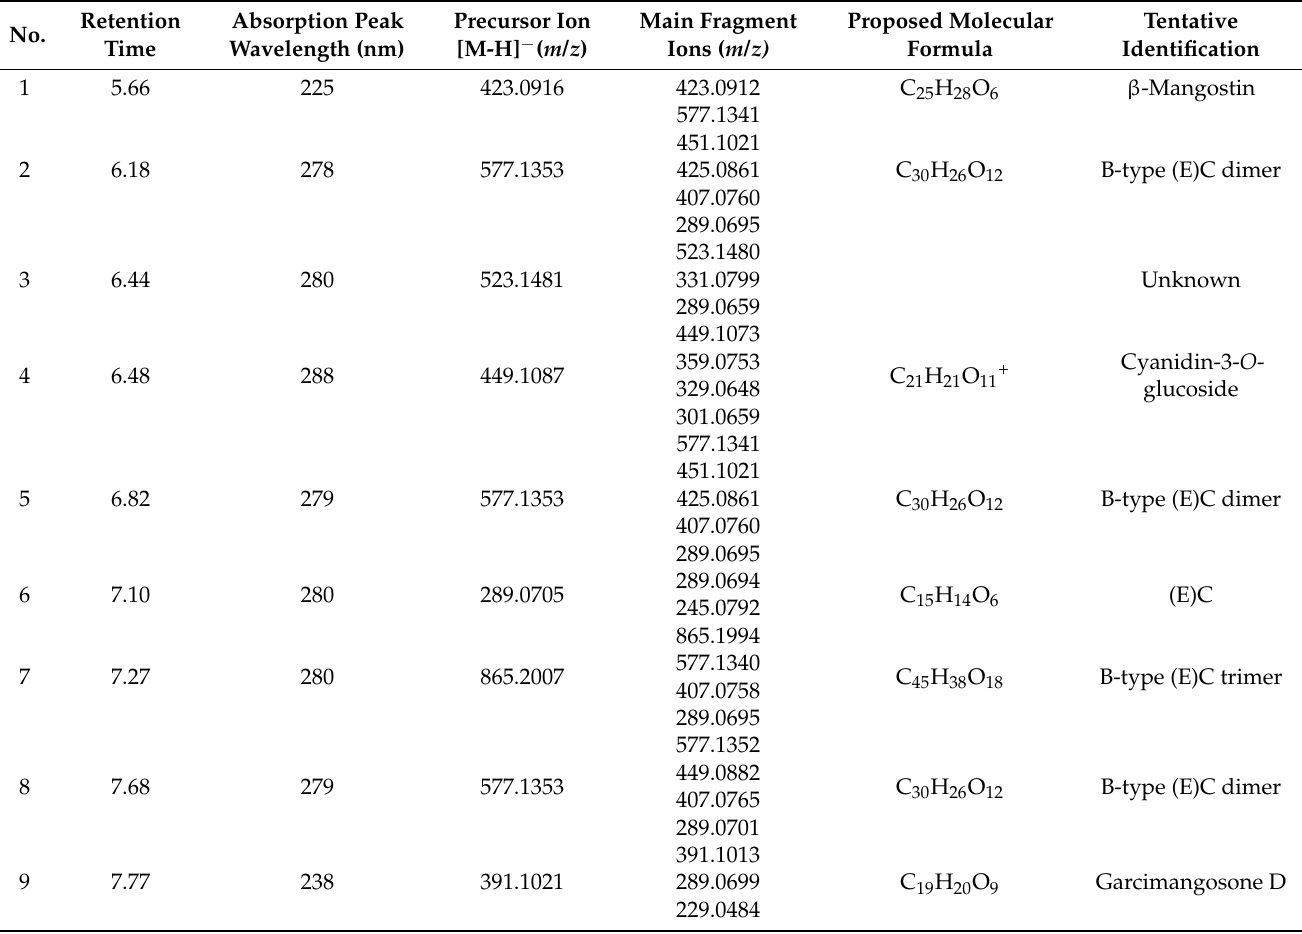
Table 2. Tentative identification by UPLC-ESI-QTOF-MS/MS of